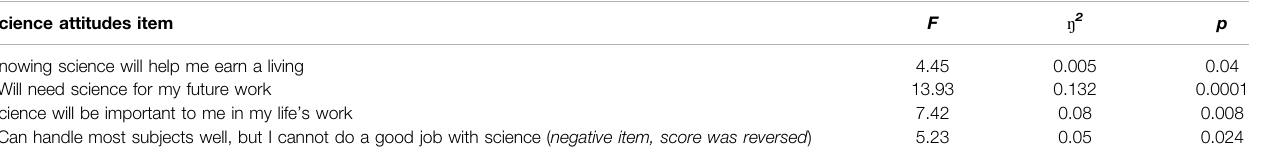
TABLE 2 | Gender differences on the posttest of Science